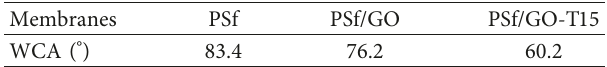
Figure 8: Water contact angle images of (a) PSf, (b) PSf/GO, and (c) PSf/GO-T15 membranes. Table 1: Water contact angle values of PSf, PSf/GO, and PSf/GO- T15